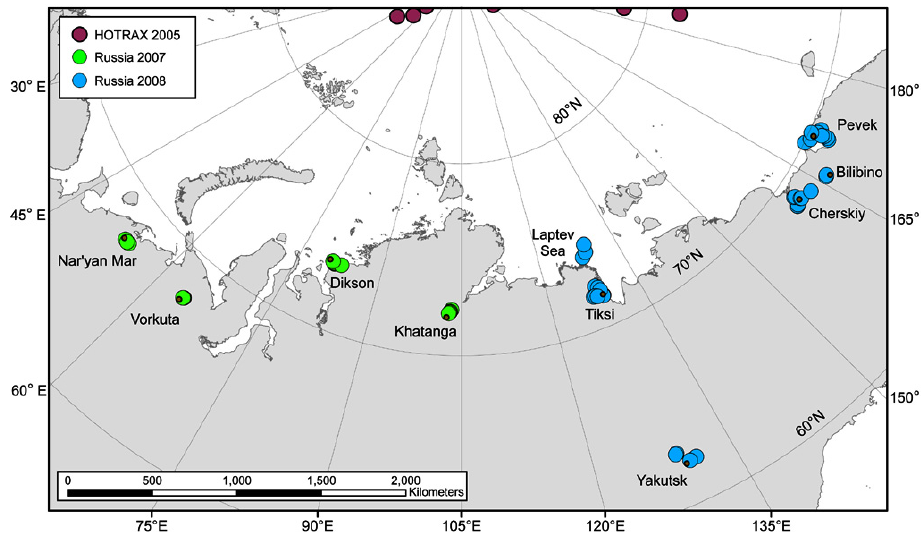
Fig. 5. Map showing sampling locations in Russia (2007 and